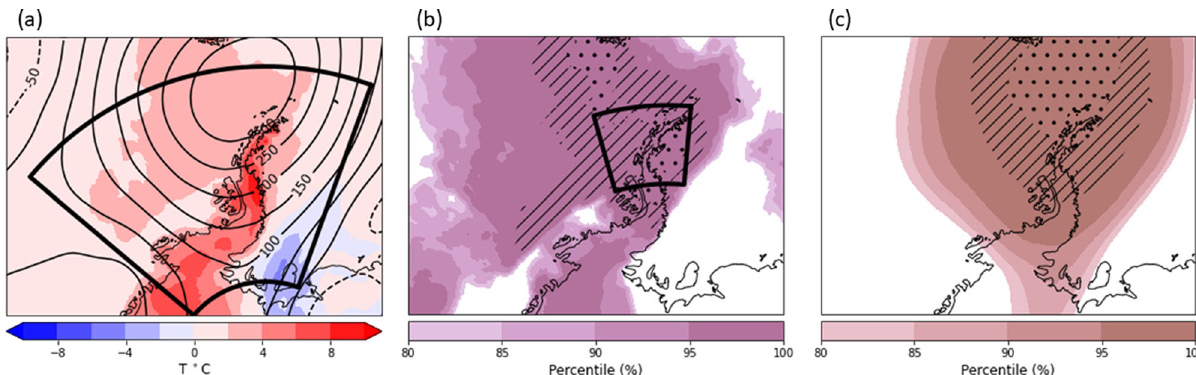
Fig. 3 Anomalies and percentiles of the 6 – 11 February 2020 heatwave. a Z500 (contours; in gpm) and T2m (shading; in °C) anomalies (wrt. 1950 – 2019) for 6 – 11 February 2020. b , c Percentiles of the 6 – 11 February 2020 mean ( b ) T2m and ( c ) Z500, with respect to the climatological distribution of 6-day running means obtained from all summer days of 1950 – 2019. Dashed and dotted regions indicate the 99 th percentile and record-breaking values, respectively. The AN and AP regions are highlighted in (a) and (b), respectively. Data source: ERA5 reanalysis.